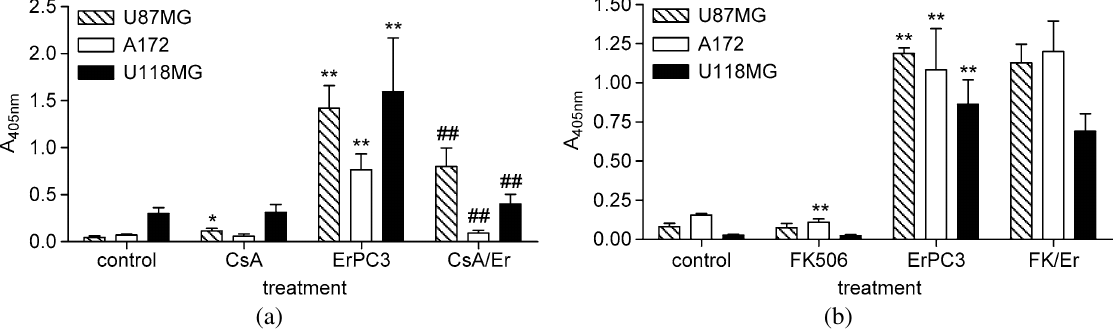
Fig. 4. The effect of the MPTP blocker, CsA (a), and of FK506 (b) on ErPC3-induced apoptosis in human glioblastoma cell lines. U87MG, A172 and U118MG cells were preincubated with 10 µM of CsA (a) and 500 nM of FK505 (b) for 1 h prior to co-incubation with ErPC3 (CsA/Er; FK/Er) for 12 h (U87MG and U118MG) and 24 h (A172). Untreated cells (control), cells treated with CsA or FK506 alone (CsA; FK506) and cells treated with ErPC3 alone were run in parallel. Unlike CsA, FK506 had no significant effect on apoptosis induction by ErPC3 in all three cell lines. Absorbance of the 405 nm wavelength is indicative for the level of apoptosis. Symbols: ∗ p < 0 . 05 vs. control; ∗∗ p < 0 . 01 vs. control; ## p < 0 . 01 vs.